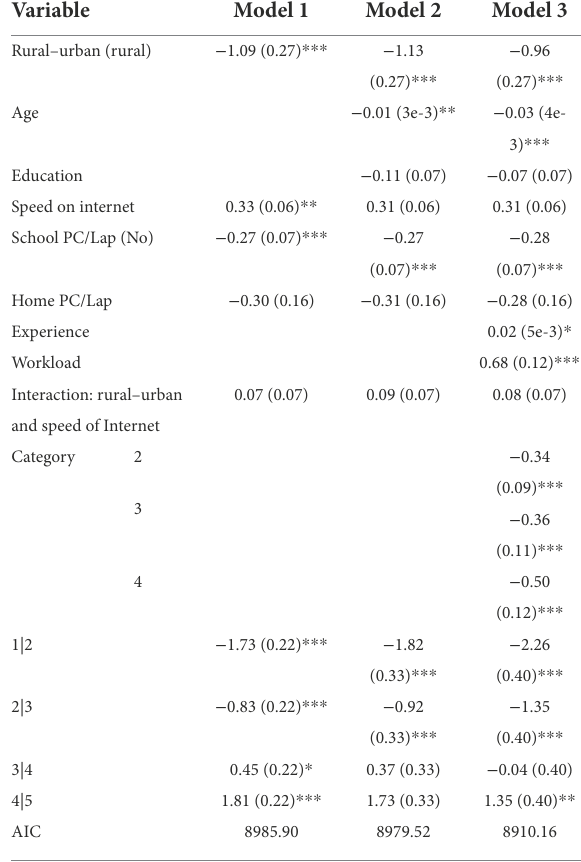
TABLE 3 Results of ordinal logistic regression models (non-centered solution, n =